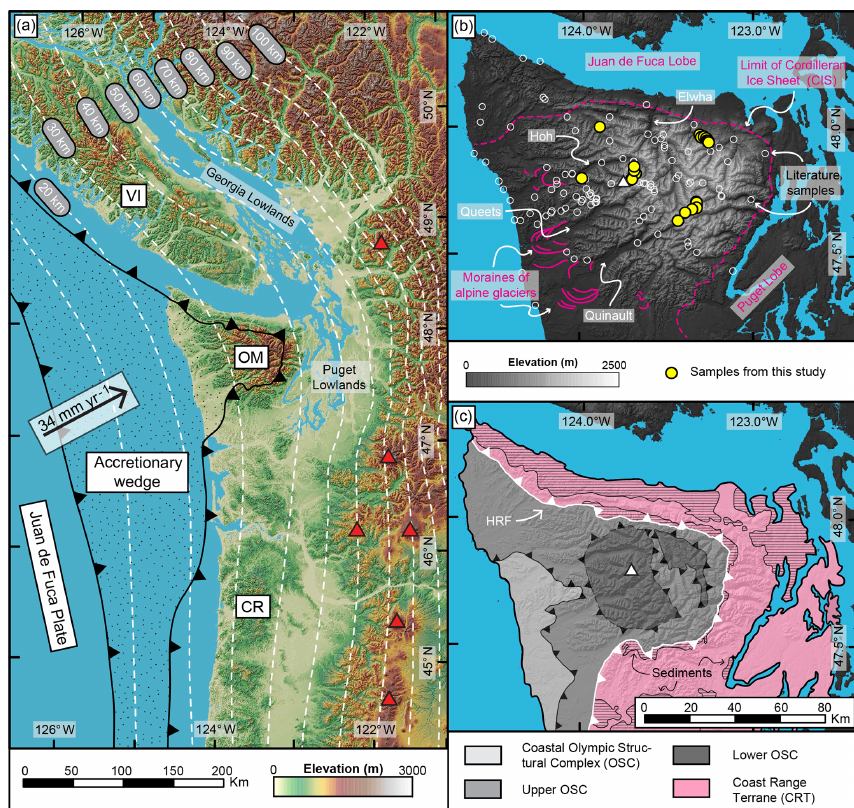
Figure 1. (a) Overview map of the Cascadia Subduction Zone showing the extent of the accretionary wedge. White dashed lines are contour lines for the top of the subducted oceanic plate from the Slab1.0 model (Hayes et al., 2012; McCrory et al., 2012), the black arrow indicates the present-day convergence rate and direction at the latitude of the Olympic Mountains (Doubrovine and Tarduno, 2008), and red triangles denote the location of active volcanoes. VI: Vancouver Island, OM: Olympic Mountains, CR: Oregon Coast Range. (b) Topography of the Olympic Mountains, major river valleys (Elwha, Hoh, Quinault, Queets), and major Quaternary features are indicated. Limit of the Cordilleran Ice Sheet from Porter (1964), alpine moraines after geologic map of Tabor and Cady (1978). Locations of samples from this study (filled yellow circles) and previous studies (open white circles) are indicated. The white triangle denotes the location of Mt. Olympus. (c) Geologic and structural map of the Olympic Mountains after Tabor and Cady (1978) and Brandon et al. (1998). The line pattern indicates the occurrence of sediments within the Coast Range Terrane. HRF: Hurricane Ridge